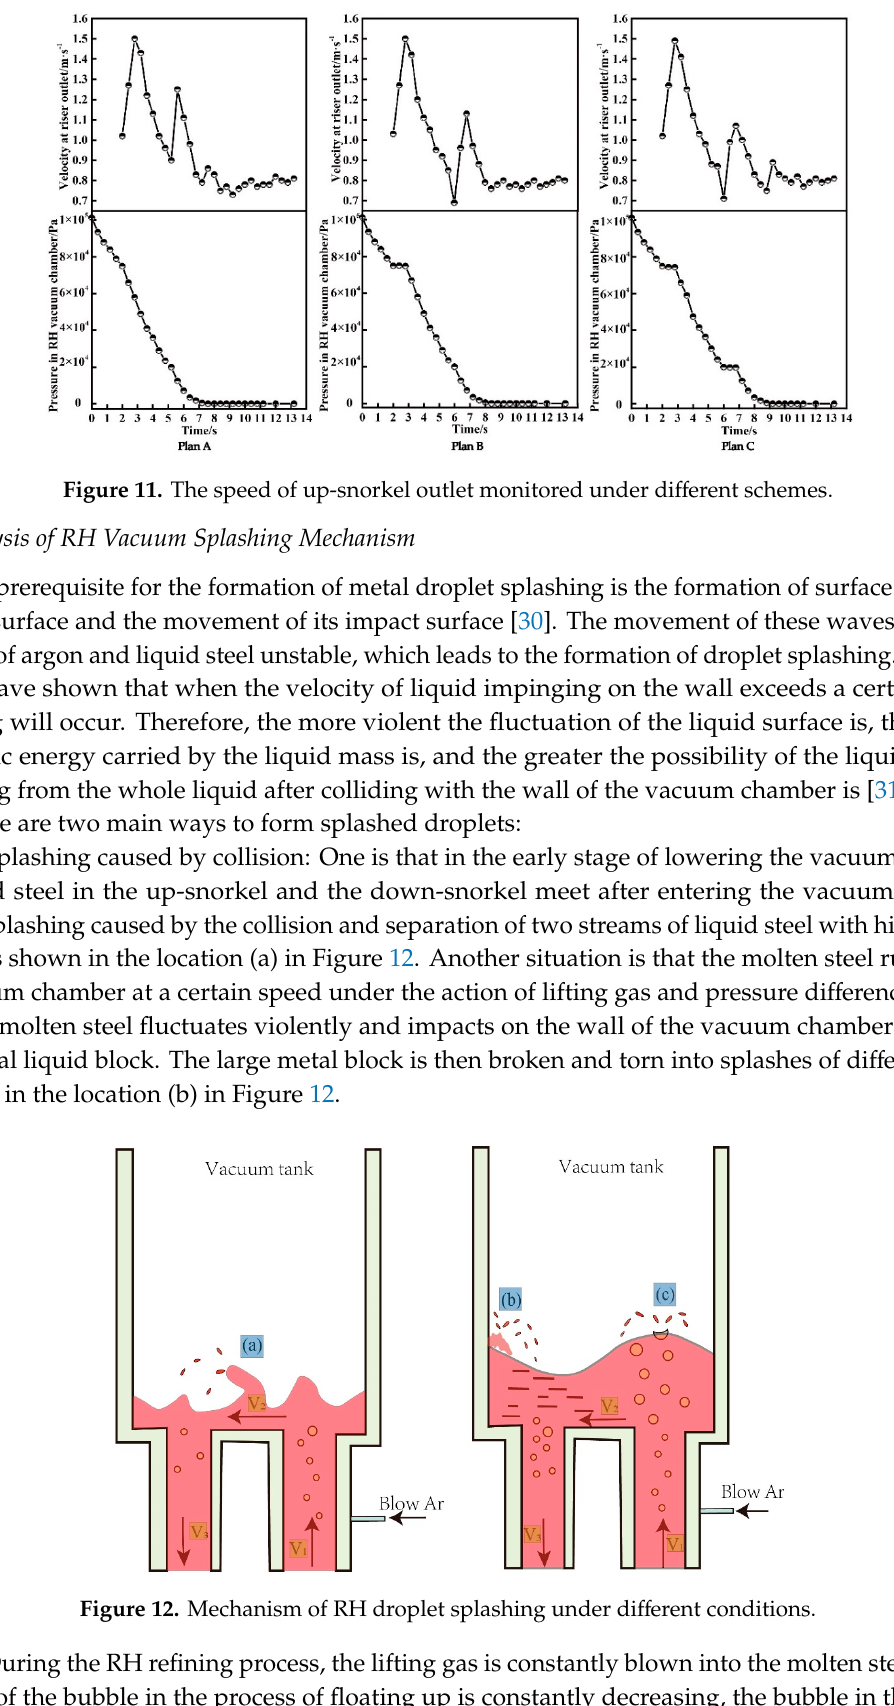
Figure 10. Velocity vector cloud chart of molten steel in RH vacuum reactor.